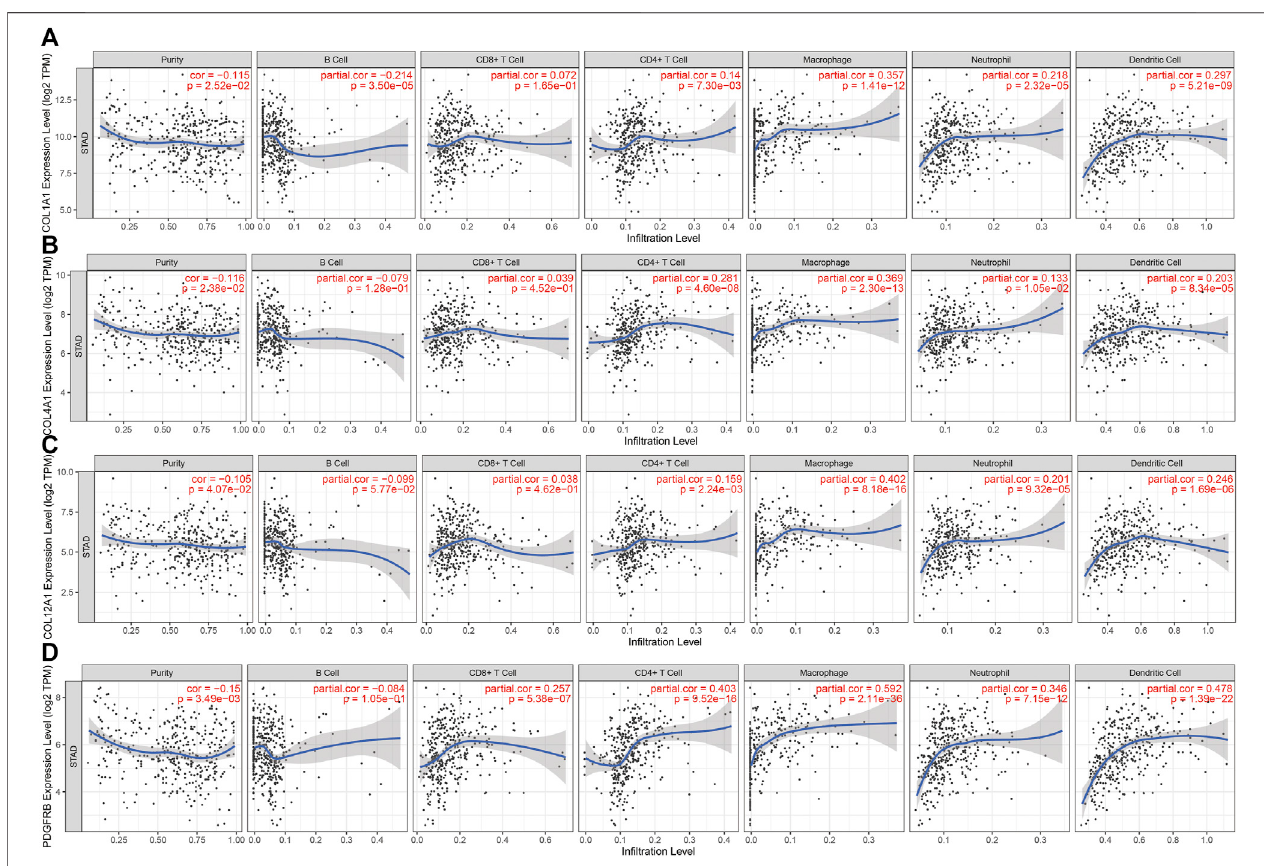
FIGURE5| Correlationbetweenhubgenesexpressionandimmunecellin fi ltrationinSTADintheTCGAcohort. (A) .COL1A1 (B) .COL4A1 (C) .COL12A1and (D). PDGFRB.